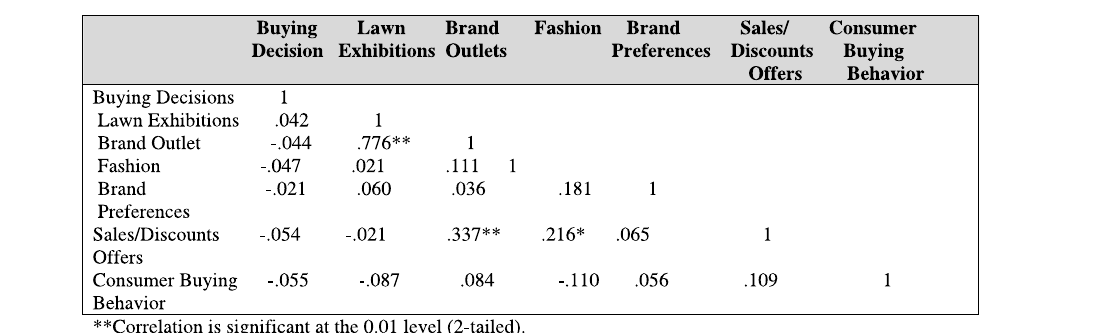
Table 7 : Exhibition’s